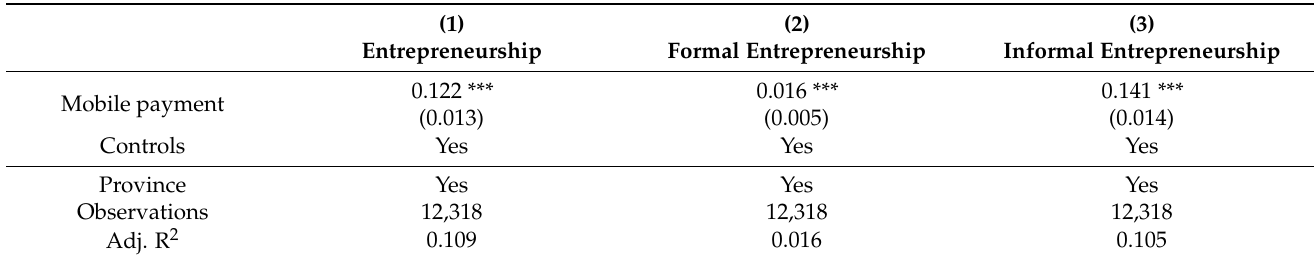
Table 11. Mechanism analysis: stimulating